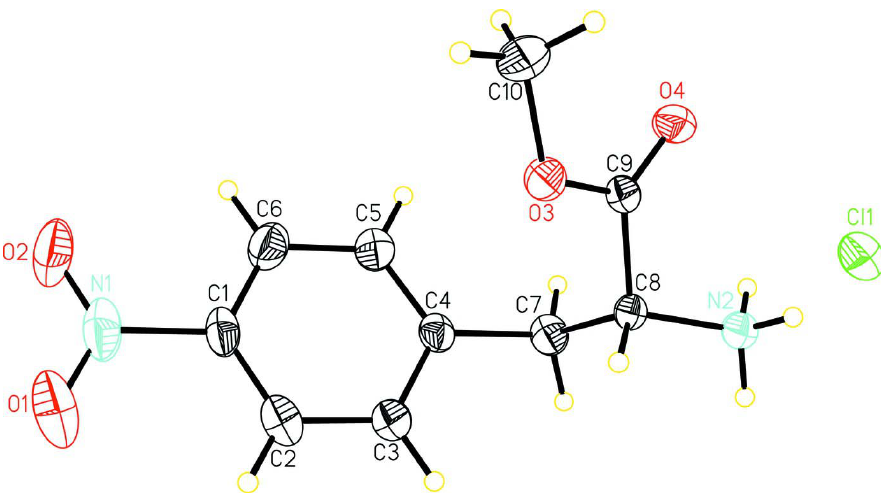
Figure 1 A view of the title compound with the atomic numbering scheme. Displacement ellipsoids were drawn at the 30% probability level. H atoms are represented as small spheres of arbitrary